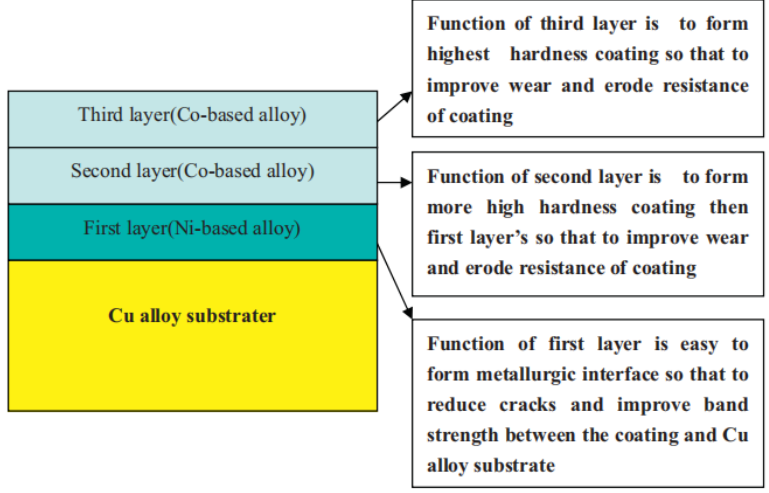
Figure 29. The structure and function of designing three-layer gradient coatings [140].